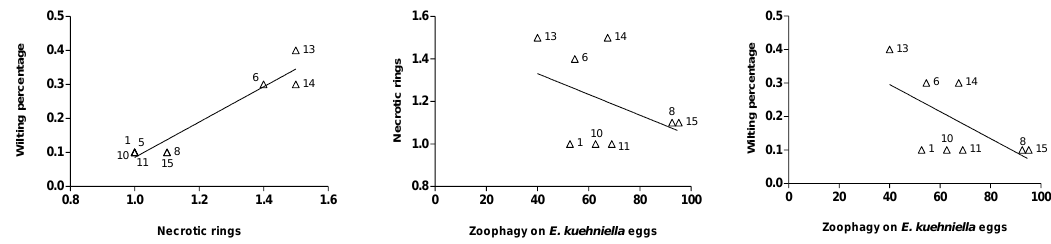
Figure 4. Correlation between wilting percentage and necrotic rings, and necrotic rings and zoophagy on E. kuehniella eggs, and wilting percentage and zoophagy on E. kuehniella eggs by N. tenuis on tomato leaves. Numbers represent the isofemale lines ID.